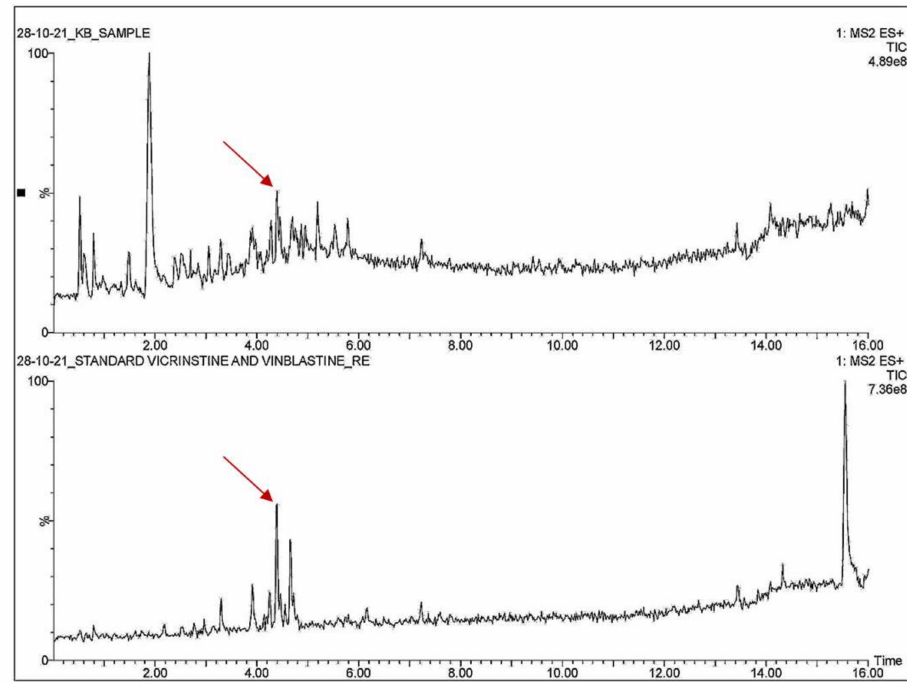
Figure 5. LC–MS chromatogram for vincristine in sample and vincristine standard.